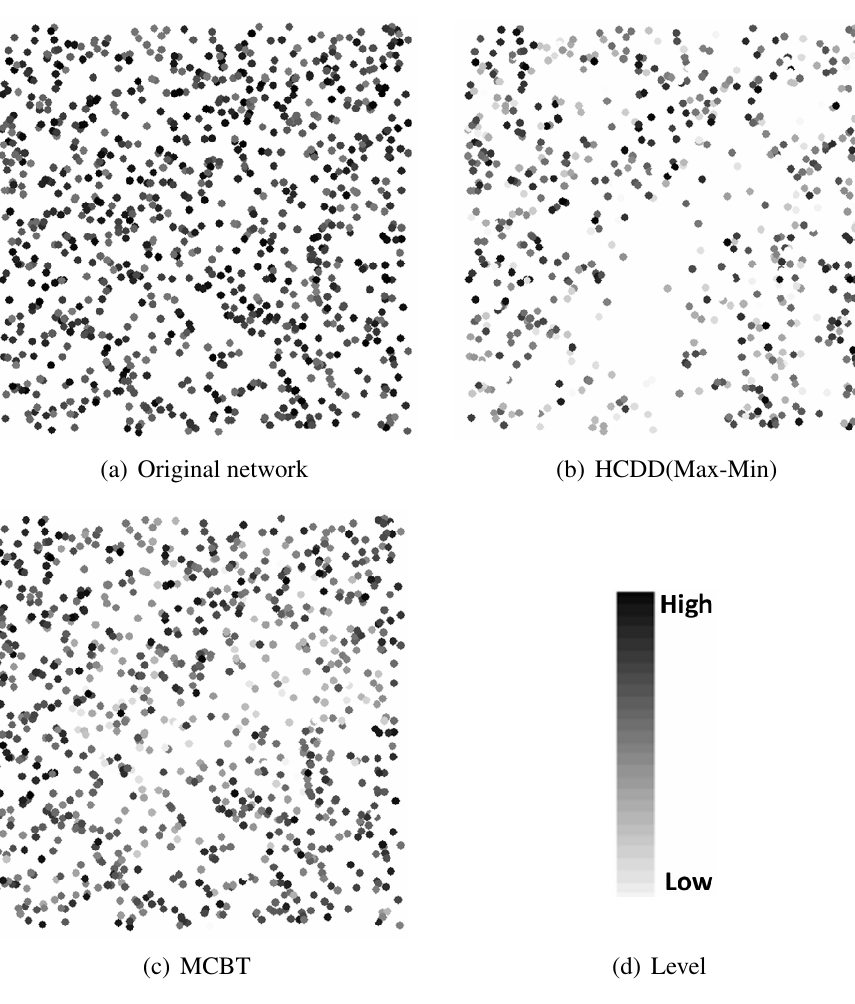
Figure 9. Remaining energy of nodes after event